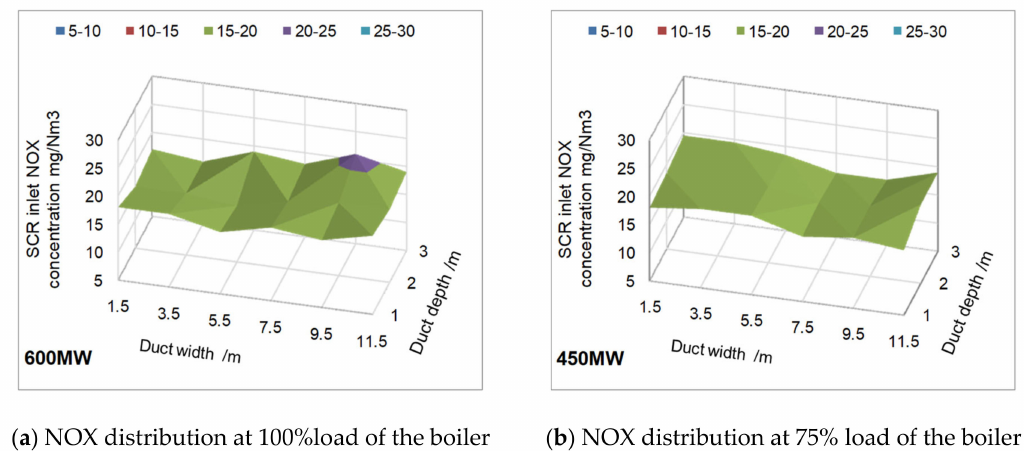
Figure 10. NOX distribution at SCR outlet in a 600-MW unit at di ff erent loads.